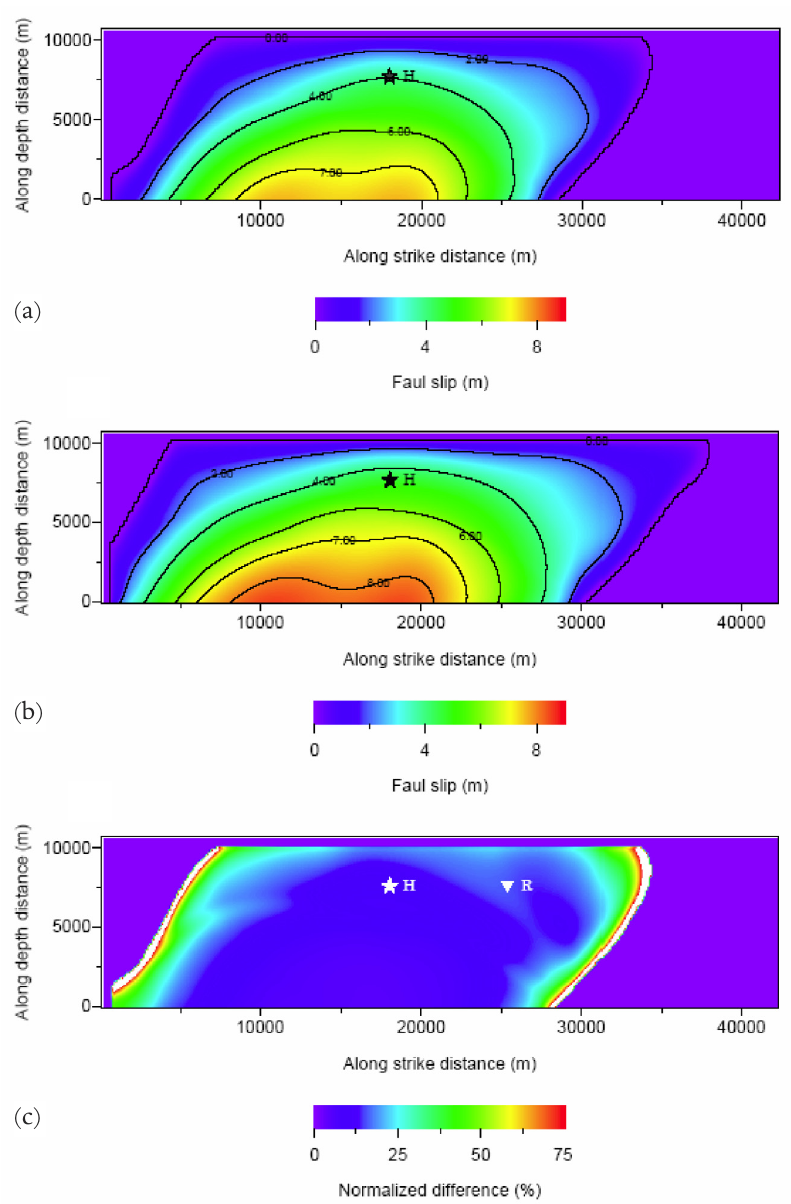
Figure 9. Slip distribution of the fault slip at t = 3.8 s arising from the adoption of the formulation (1) (panel (a)) and formulation (2) (panel (b)) for Model C (see Table 1). (c) Misfit